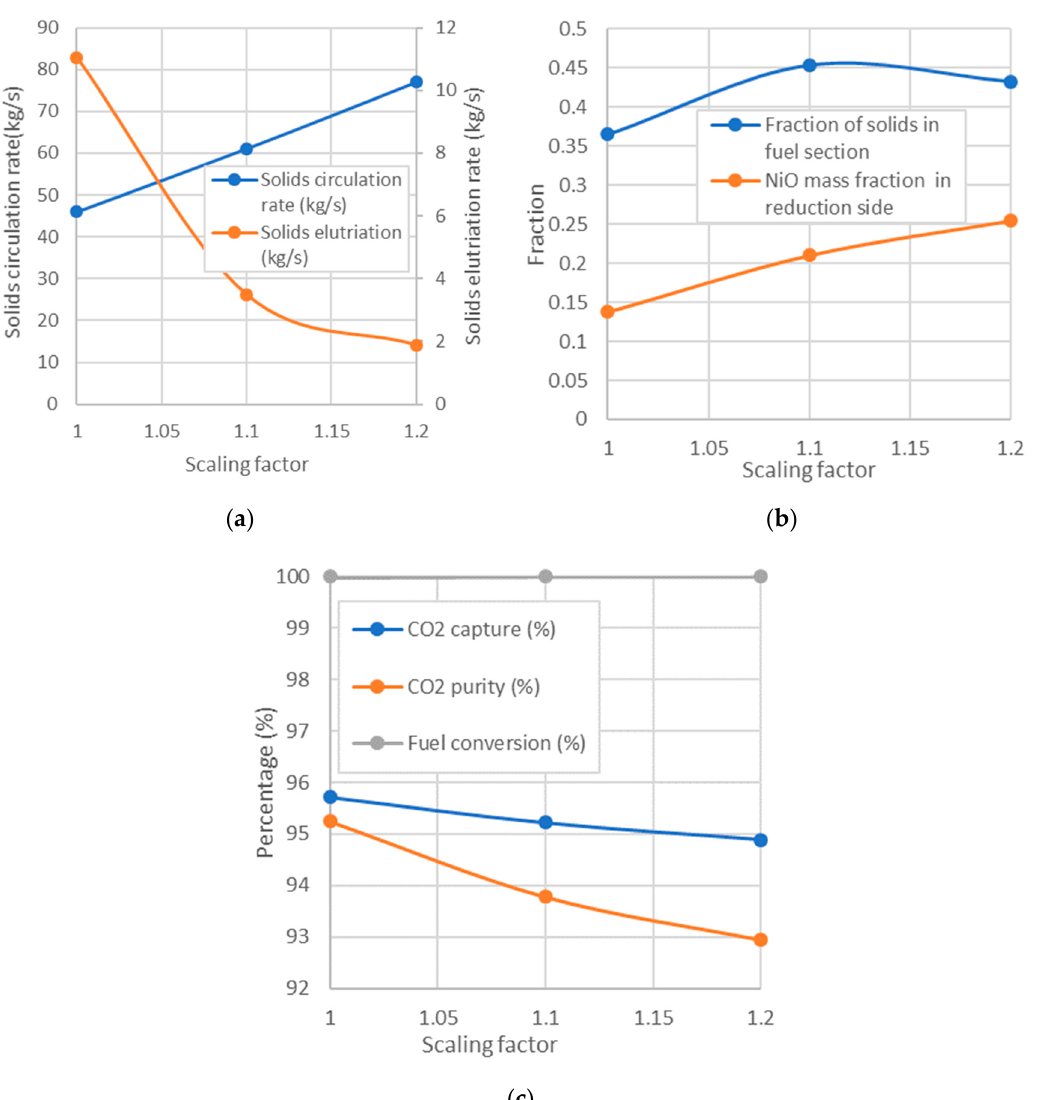
Figure 11. Summary of important time-averaged properties of the ICR as a function of the reactor size scaling factor: ( a ) solids circulation and elutriation rates; ( b ) fraction of solids and NiO mass fraction in the reduction side; ( c ) CO 2 capture, CO 2 purity, and fuel conversion.